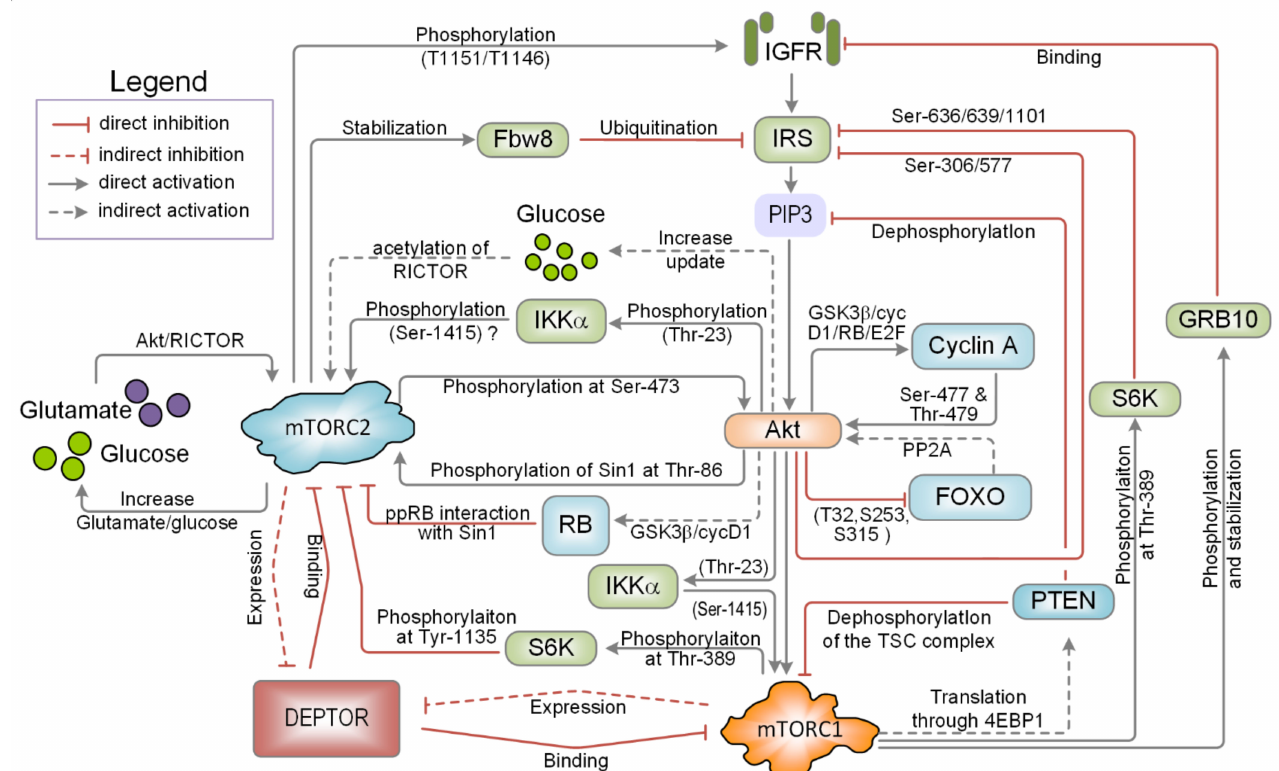
Figure 2. A schematic diagram in the form of flowchart that depicts explicitly multiple feedback and feed-forward loop mechanisms emerging from within the PI3K/mTOR pathway and its crosstalk with other pathways. For each mechanism, the underlying biological details are highlighted. mTORC2 phosphorylates IR and IGF-IR on tyrosine residues 1131/1136 and 1146/1151. mTORC2 stabilises Fbw8 to translocate into the cytosol and ubiquitinate IRS1. Akt enhances glucose uptake, which activates mTORC2 through acetyl-CoA-mediated acetylation of RICTOR. IKK α is phosphorylated at Thr-23 and activated by Akt, which leads to activation of mTORC1 through the phosphorylation at Ser-1415 residue and mTORC2 via an unknown mechanism. mTORC2 phosphorylates Akt at Ser-473 and activated Akt phosphorylates Sin1 at Thr-86 and consequently activates mTORC2. Akt promotes Rb hyper-phosphorylation through inhibition of GSK3 β and cyclin D1. Hyper-phosphorylated Rb binds to and inhibits Sin1, leading to inhibition of mTORC2. mTORC1 phosphorylates (at Thr-389) and activates S6K1, which in turn phosphorylates RICTOR at Tyr-1135, inhibiting the mTORC2 activity. S6K also phosphorylates IRS1 at Ser-636/639/1011, causing IRS1 inhibition. DEPTOR blocks mTORC1/2 activation and mTORC1/2 downregulate DEPTOR. mTORC1 phosphorylates and stabilizes Grb10, which is linked to inhibition of IR/IGFR. PTEN dephosphorylates TSC1/2, which blocks mTORC1 activation. mTORC1 increases eIF4E activity, resulting in upregulation of PTEN translation and expression. Akt phosphorylates and inhibits FOXO. Unphosphorylated FOXO inhibits PP2A, which dephosphorylates Akt and blocks its activity. Akt enhances cyclin A expression. The cyclin A2-CDK2 complex phosphorylates Akt at Ser-477 and Thr-479, which stabilises Akt Ser-473 phosphorylation and promotes Akt activity. Glucose uptake is enhanced by Akt, leading to activation of mTORC2 through acetyl-CoA-mediated RICTOR